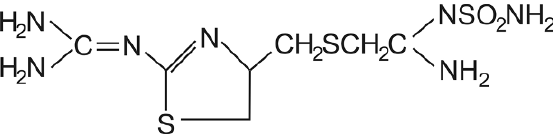
Figure 1. Structure of